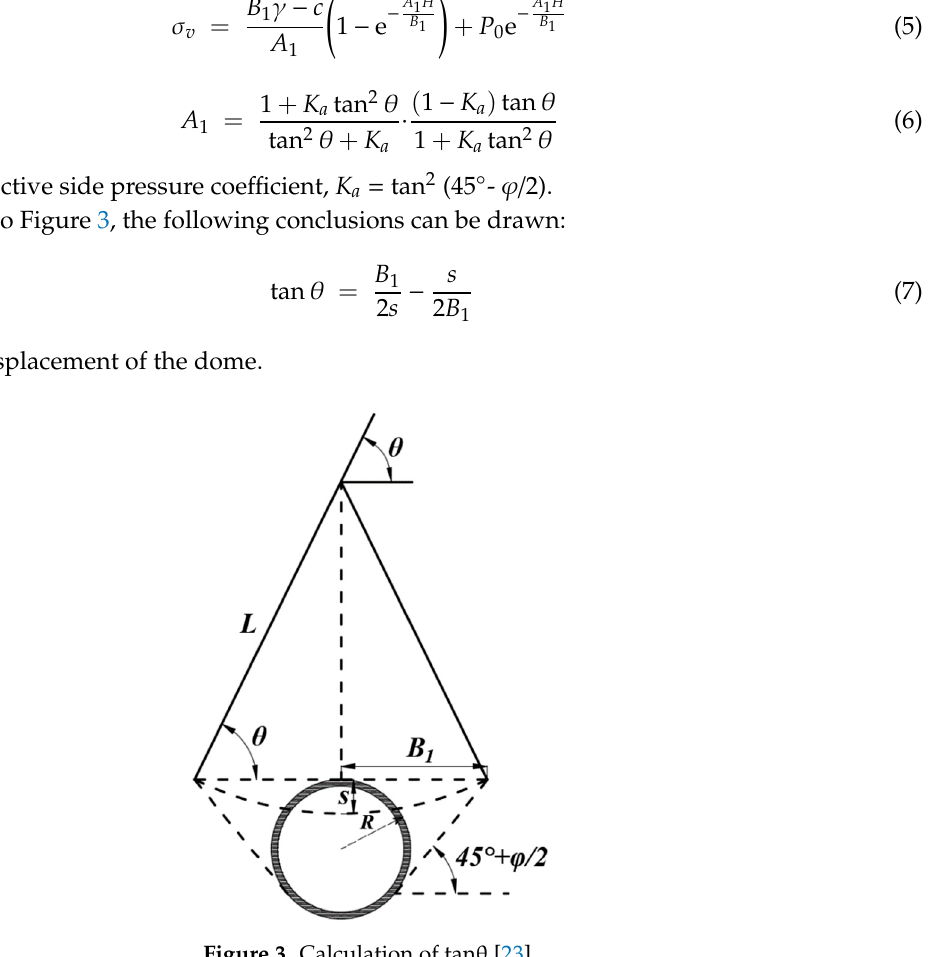
Figure 3. Calculation of tan θ [23].